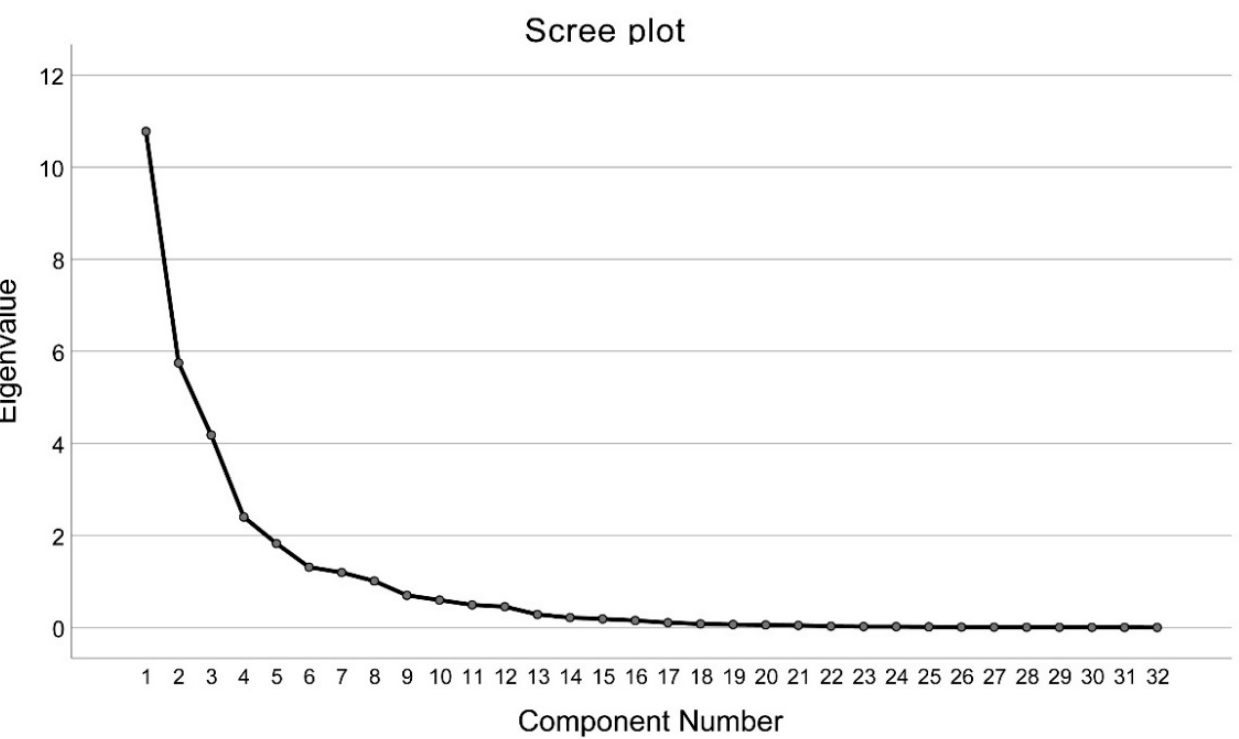
Figure 1. The scree plot of factor analysis by using dietary fatty acids data among 2806 controls. Table 2 displays factor loadings for 32 fatty acids. Factor 1 was named the even- long-chain fatty acid pattern for containing 16-, 18-, and 20-carbon fatty acids, with high Table 2. Factor loadings of four dietary fatty acid patterns determined in 2806 control subjects. factor loading for oleic acid (18:1), palmitic acid (16:0), stearic acid (18:0), palmitoleic